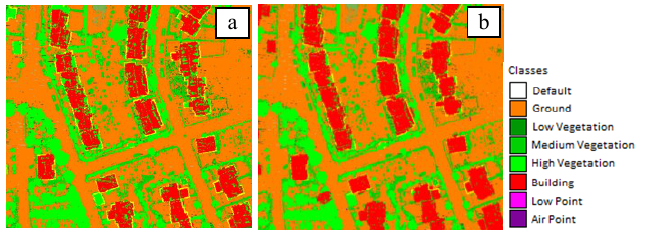
Figure 3. The results of the building class parameter analyses before (a) and after